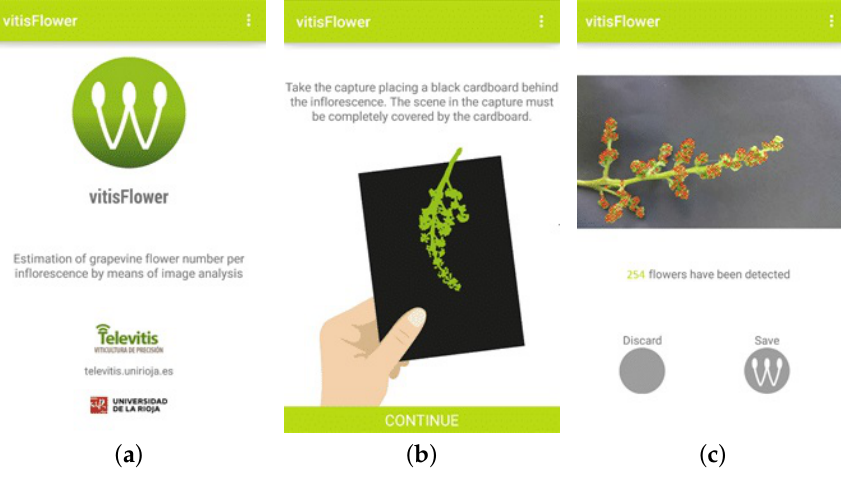
Figure 28. vitisFlower: ( a ) Main menu; ( b ) Use instructions; ( c ) Flower detection result.